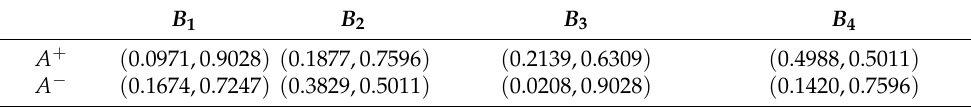
Table 4. Positive and negative ideal solutions for Aleeza.